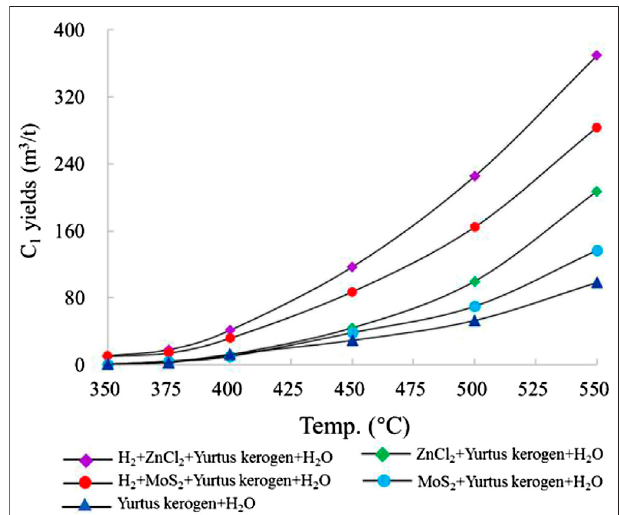
FIGURE1| CharacteristicsofC 1 yieldsimulatedunderdifferentcatalytic hydrogenation control conditions of the closed system.